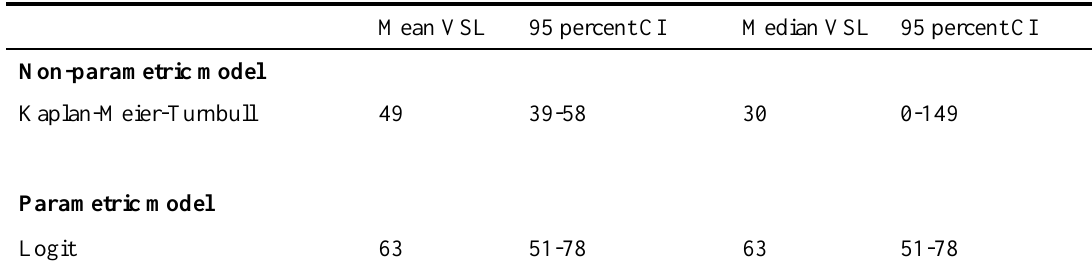
Table 2: Mean and median VSL (million SEK) Mean VSL 95 percent CI Median VSL 95 percent CI Non-parametric model